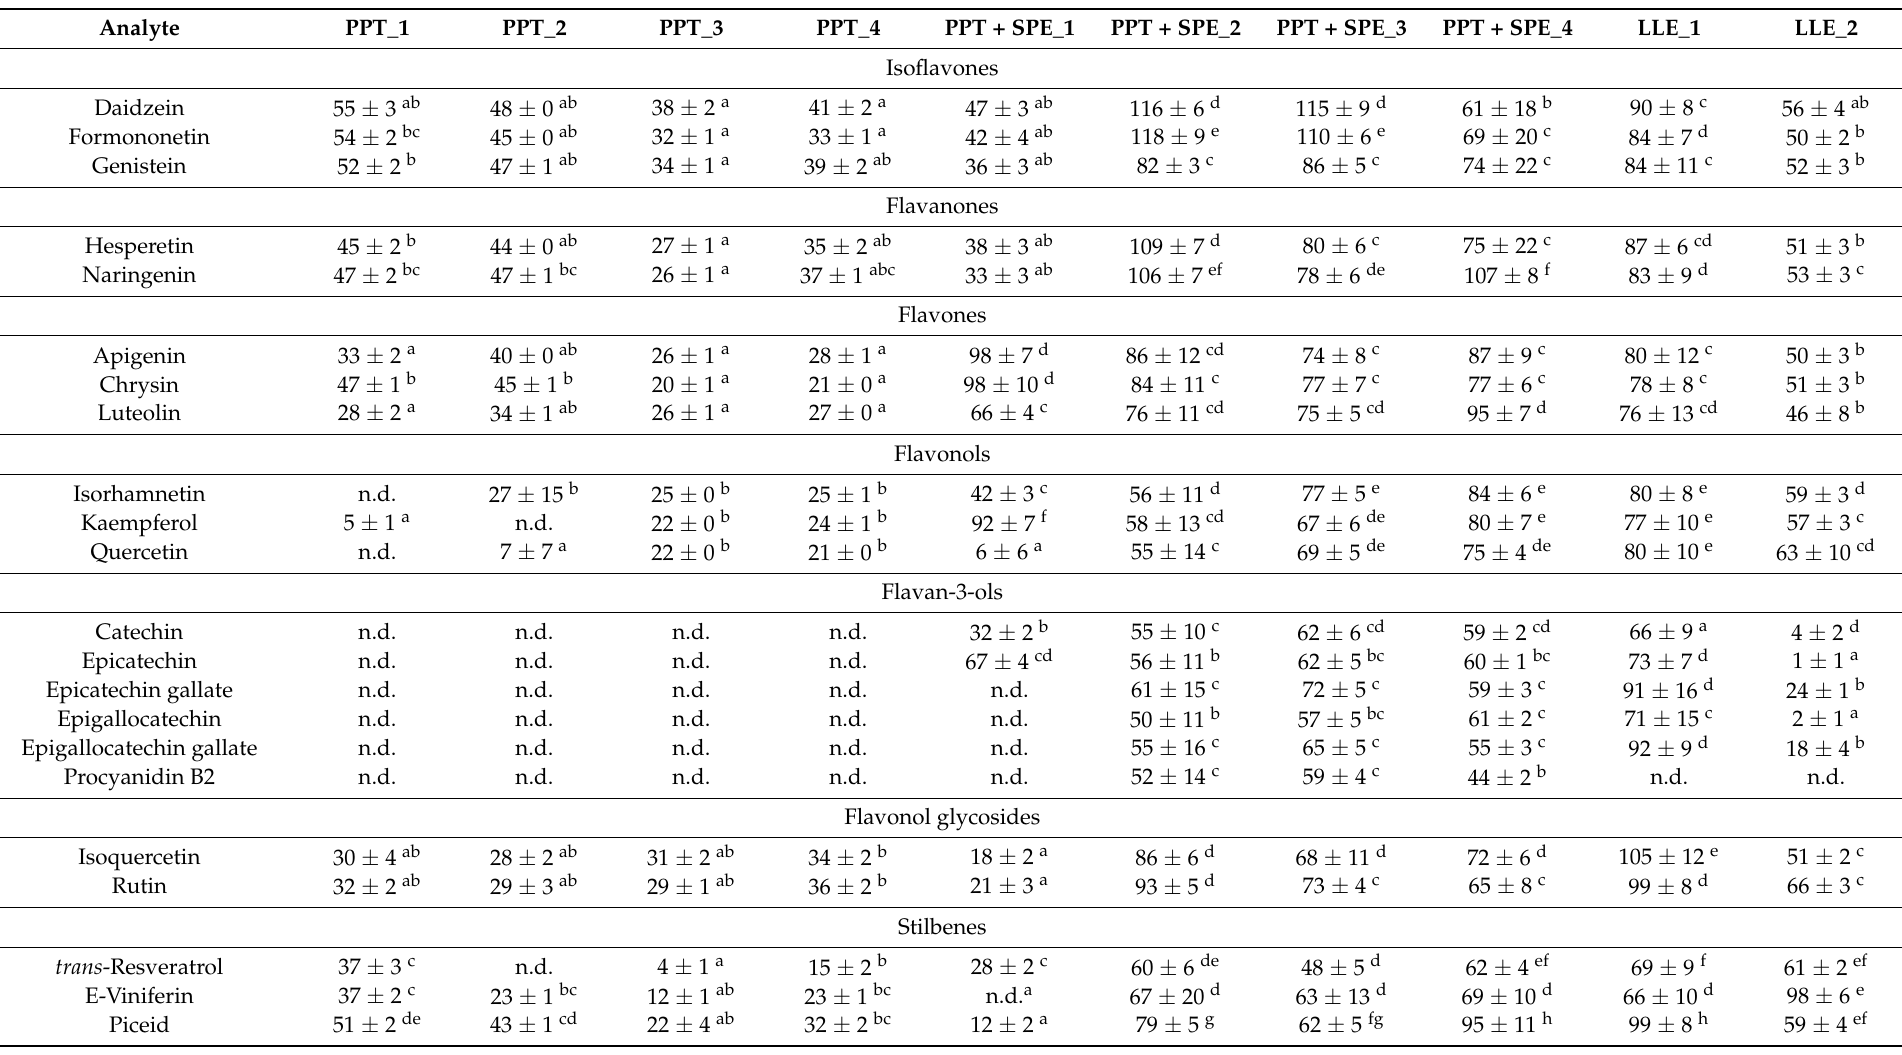
Table 1. Recovery (%R) data of the studied polar phenols after testing ten different sample preparation methods for plasma (n = 3). Analyte PPT_1 PPT_2